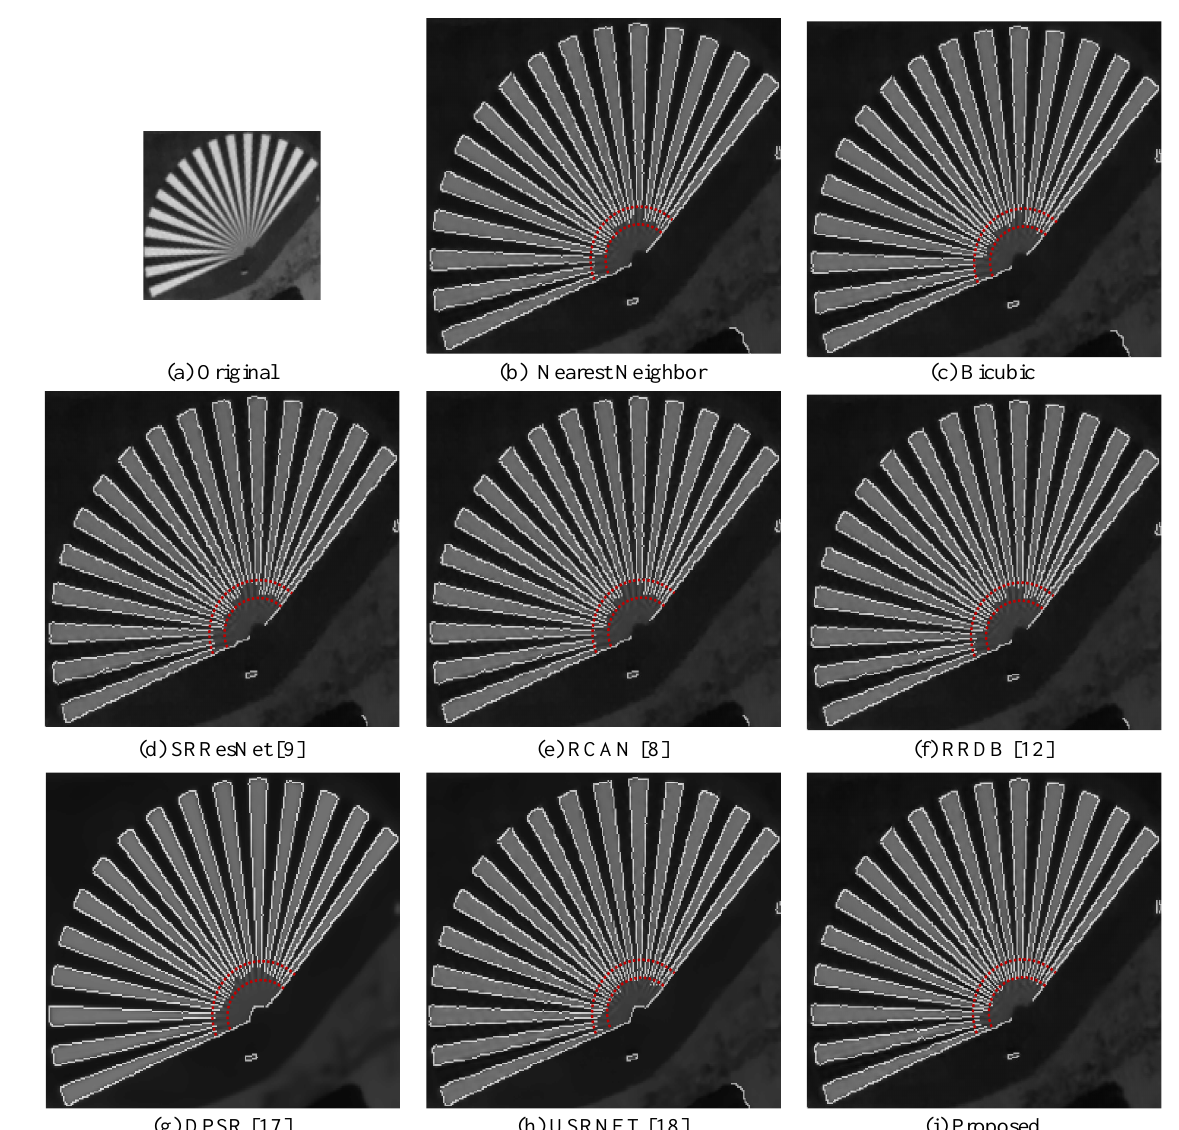
Figure 13. Fan-shaped target SR results: ( a ) Original, ( b ) Nearest Neighbor, ( c ) Bicubic, ( d ) SRResNet, ( e ) RCAN, ( f ) RRDB, ( g ) DPSR, ( h ) USRNET, ( i )